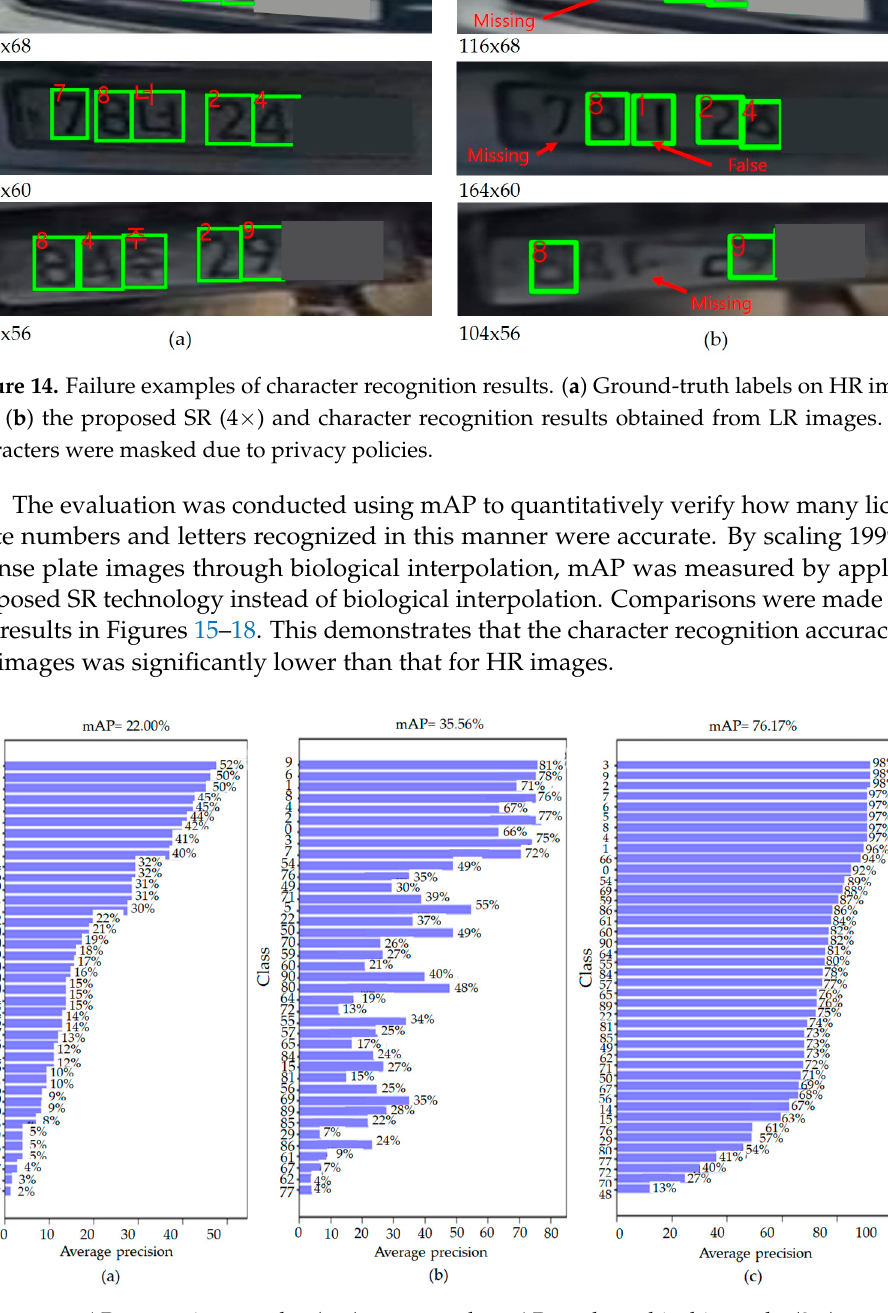
Figure 15. mAP comparison results. ( a – c ) represent the mAP results on bicubic results (3 × ), proposed SR results (3 × ), and HR images, respectively.